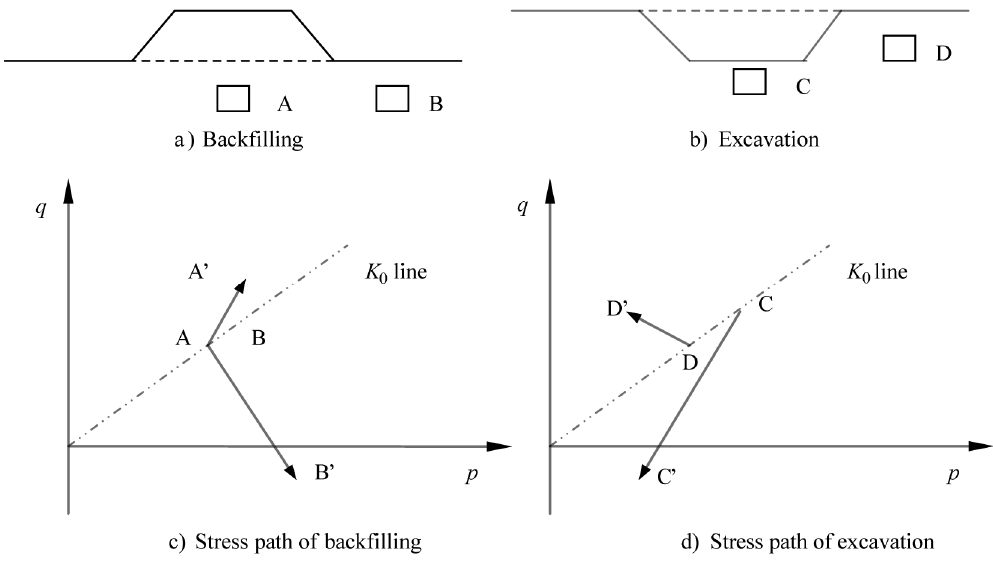
Fig. 1. Typical stress path of a slope